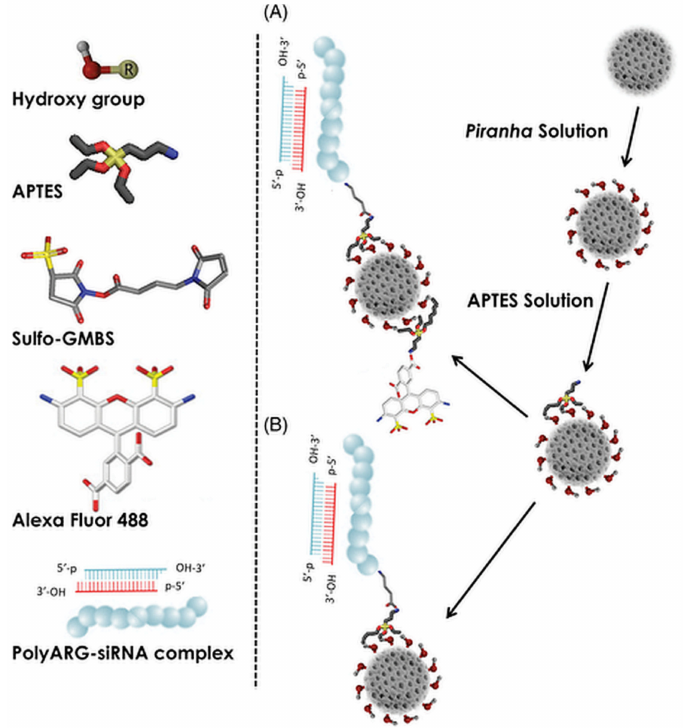
Figure 7. Synthesis of the TEMPO-APTES derivative and subsequent immobilization on frustule biosilica. Adapted from [68], copyright (2015), with permission from John Wiley and Sons.